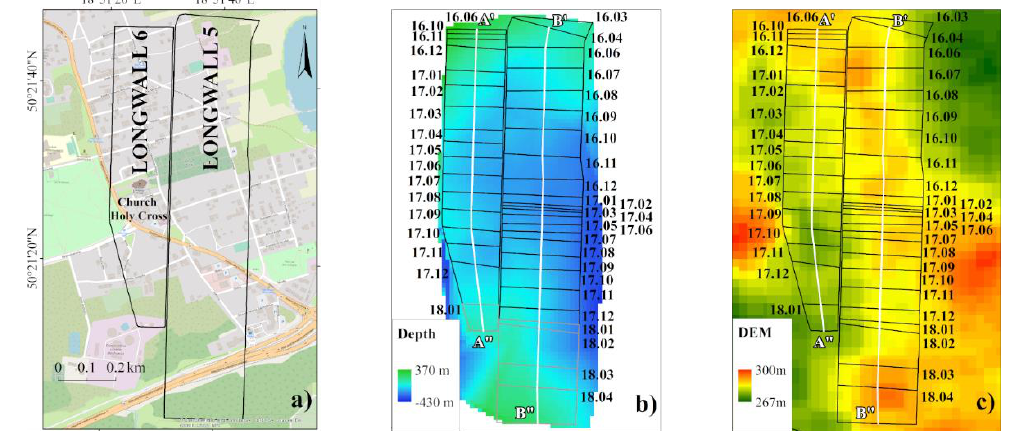
Figure 9. ( a ) The range of the investigated longwalls No. 5 and 6 from seam 503 of the Bytom-III mining area located in the northern part of USCB (see Figure 8 right); ( b ) depth of the longwalls with respect to the sea level. The numbers represent the starting date (YY.MM) for extractions from the corresponding panel; ( c ) terrain elevation above the mined area from Shuttle Radar Topography Mission (SRTM) Digital Elevation Model (DEM).